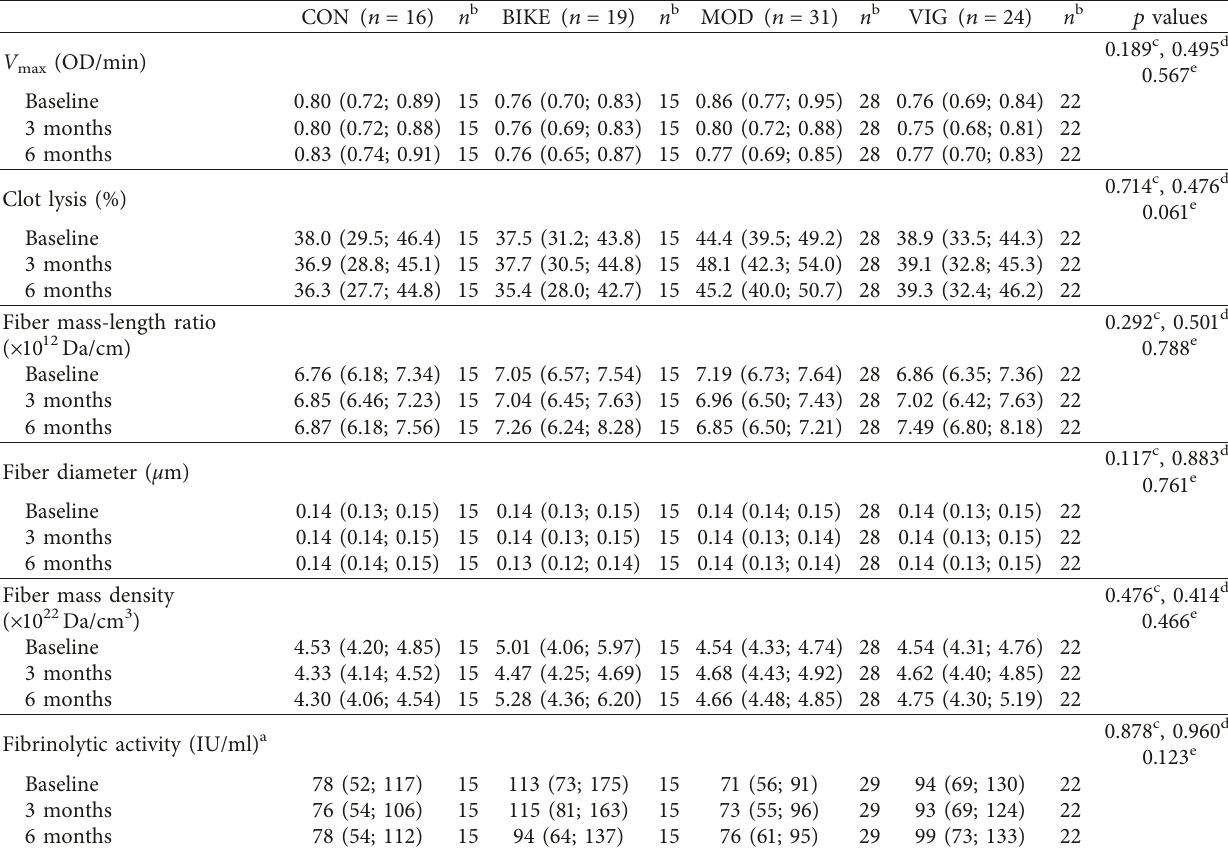
Table 4: Measures of the fibrin clot structure and fibrinolytic activity at baseline and at 3 and 6